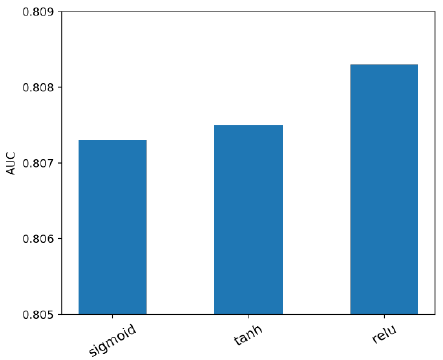
Figure 5. The impact of activation function on the model.